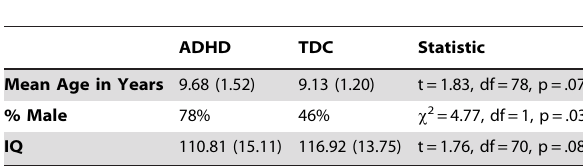
Table 1. Demographics of empirical